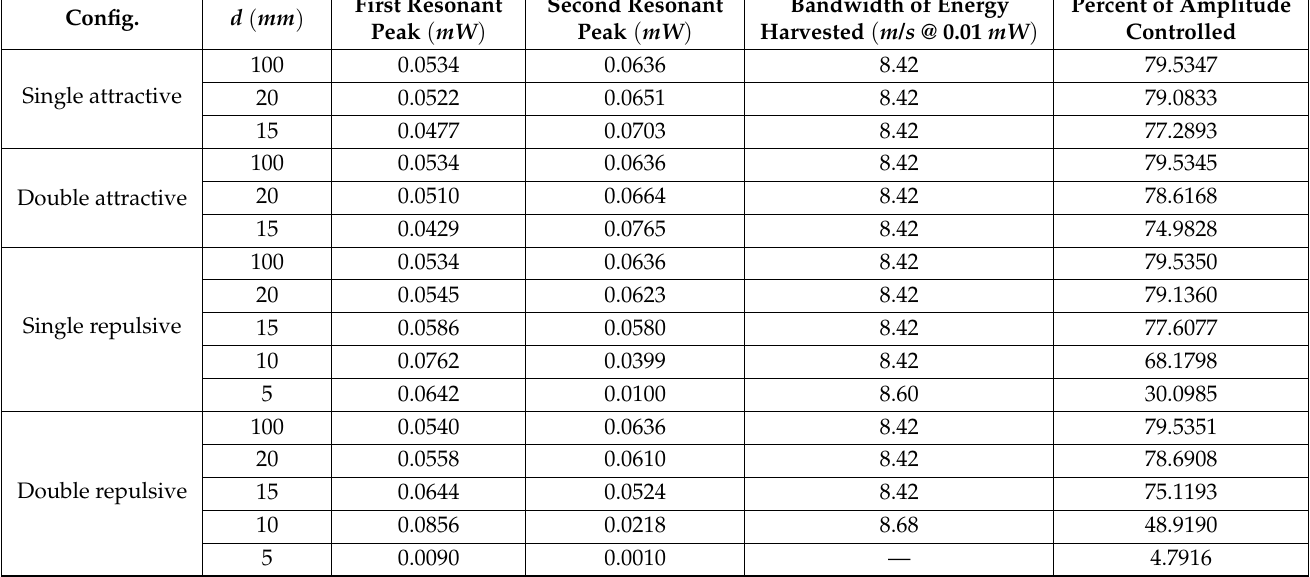
Table A1. Summary of quantities of interest for attractive and repulsive